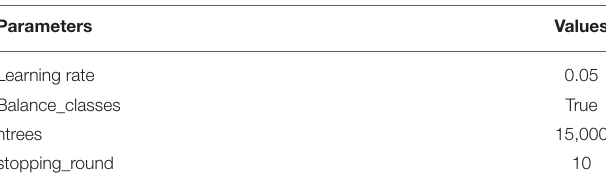
TABLE 2 | Parameters for GBM in H 2 O library. TABLE 3 | Parameters for all DL